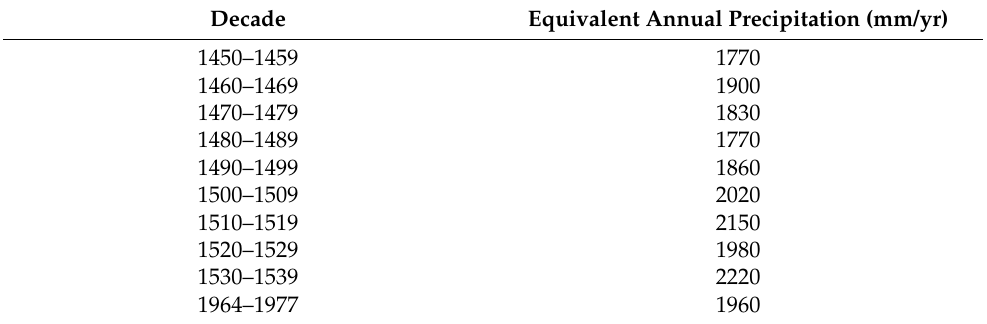
Table 1. Estimated annual precipitation at Machu Picchu by decade based on comparison of modern climatological data at Machu Picchu to data from the Quelccaya ice cap [6], located approximately 250 km southeast of Machu Picchu. Average annual precipitation at Machu Picchu was estimated at 1960 mm. (Reproduced from Machu Picchu: A Civil Engineering Marvel [5], with permission from the American Society of Civil Engineers [ASCE], the publisher.)